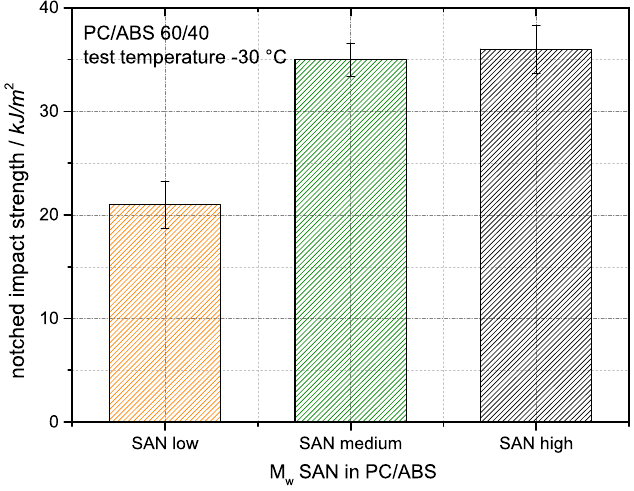
Figure 14. Effect of SAN molecular weight on the impact strength of PC/ABS blends at − 30 °C.